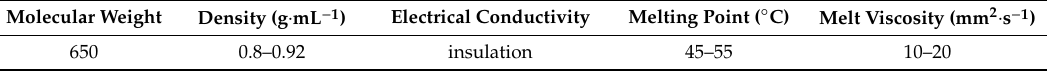
Table 1. The properties of the para ffi n